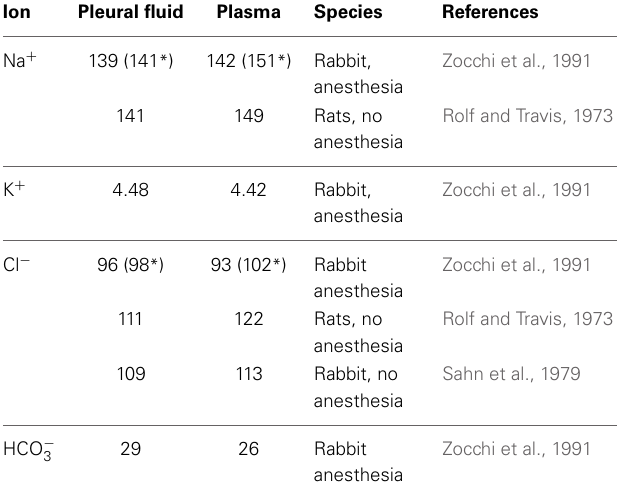
Table 1 | Comparison of ionic composition of pleural fluid and plasma.